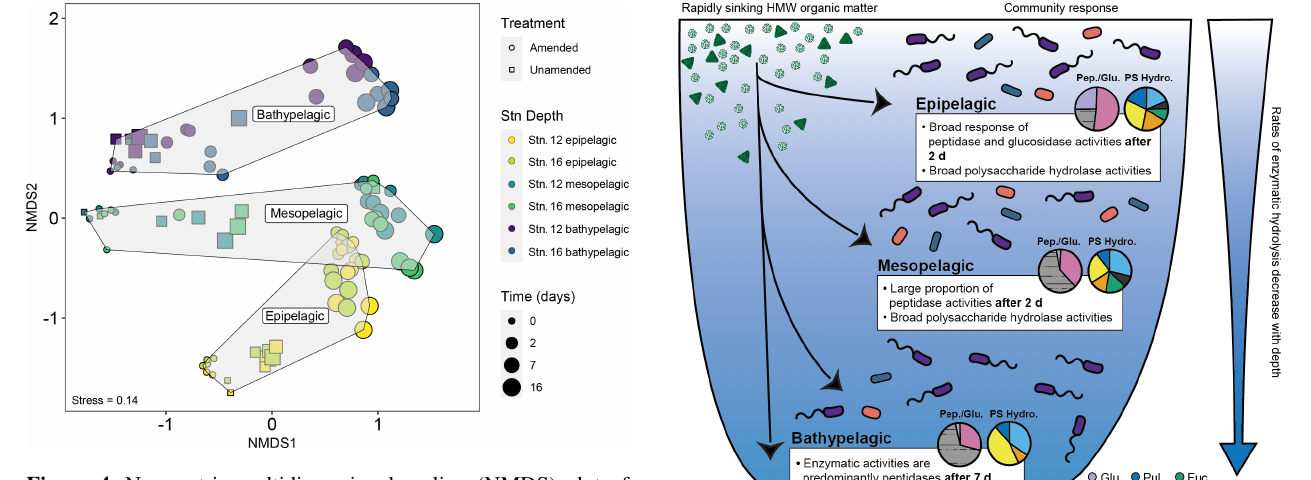
Figure 4. Non-metric multidimensional scaling (NMDS) plot of bacterial community composition based on the Bray–Curtis dissim- ilarity index shows that communities were quite distinct by depth. In later phases of the incubations, however, the amended mesopelagic and epipelagic mesocosms become more similar to one another. Note also that mesocosms from stns. 12 and 16 from a given depth and time point – especially for epipelagic and mesopelagic samples – remained similar to one another through the course of the incuba- tions.